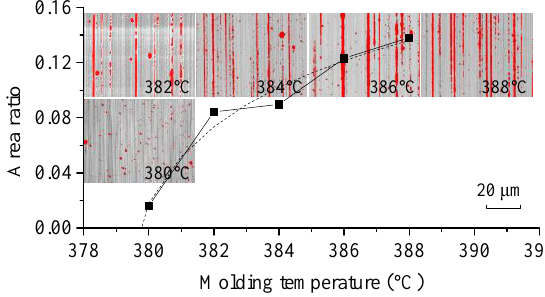
Figure 16. Area ratios of the microdimples of the formed ChG pillars at different molding temperatures under a pressing force of 1362 N.